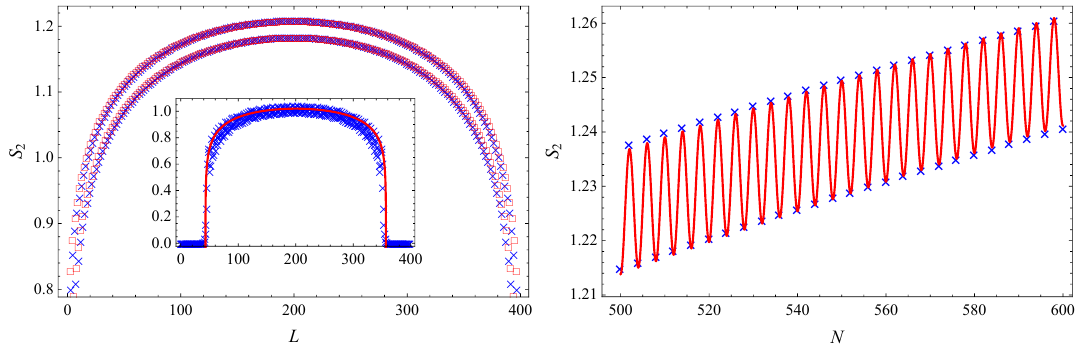
Figure 7 . Left: Rényi entanglement entropy with parameter α = 2 for the Lamé chain with N = 400 spins at half filling (blue crosses) compared to its asymptotic approximation (4.14)–(8.3) (red squares). The inset shows the analogous plot for the Fermi momentum k F = π/ 4 compared to the heuristic approximation (6.8)–(8.5) (red line). Right: Rényi entanglement entropy S 2 for the Lamé chain with λ = 1 / 2 for an even number of spins N in the interval [500 , 600] at half filling (blue crosses) compared to its approximation (4.14)–(8.3) with ( − 1) L replaced by sin((2 L + 1) π/ 2) (red